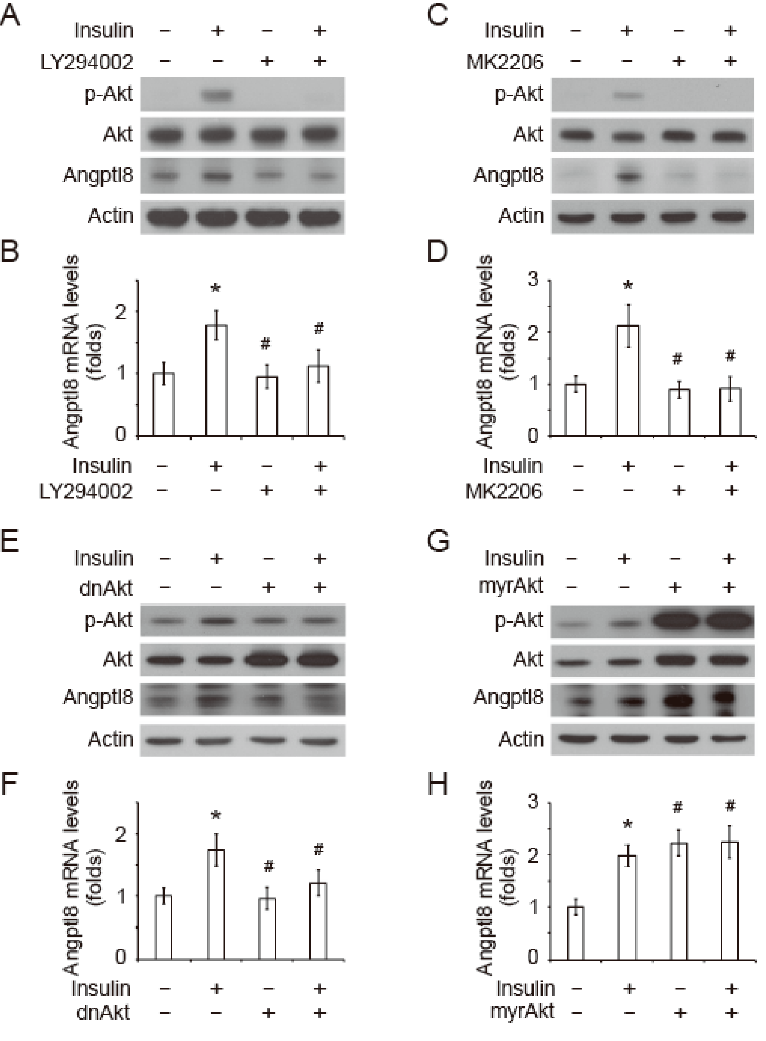
Figure 3. Insulin-induced Angptl8 is mediated by the PI3K / Akt signaling pathway. ( A – B ) The primary hepatocytes were incubated in the culture medium with or without insulin (1 µ M) and LY294002 (10 µ M) for 1 h. The expression of indicated proteins ( A ) and Angptl8 mRNA ( B ) was examined by medium with or without insulin (1 µ M) and MK2206 (10 µ M) for 1 h. The expression of